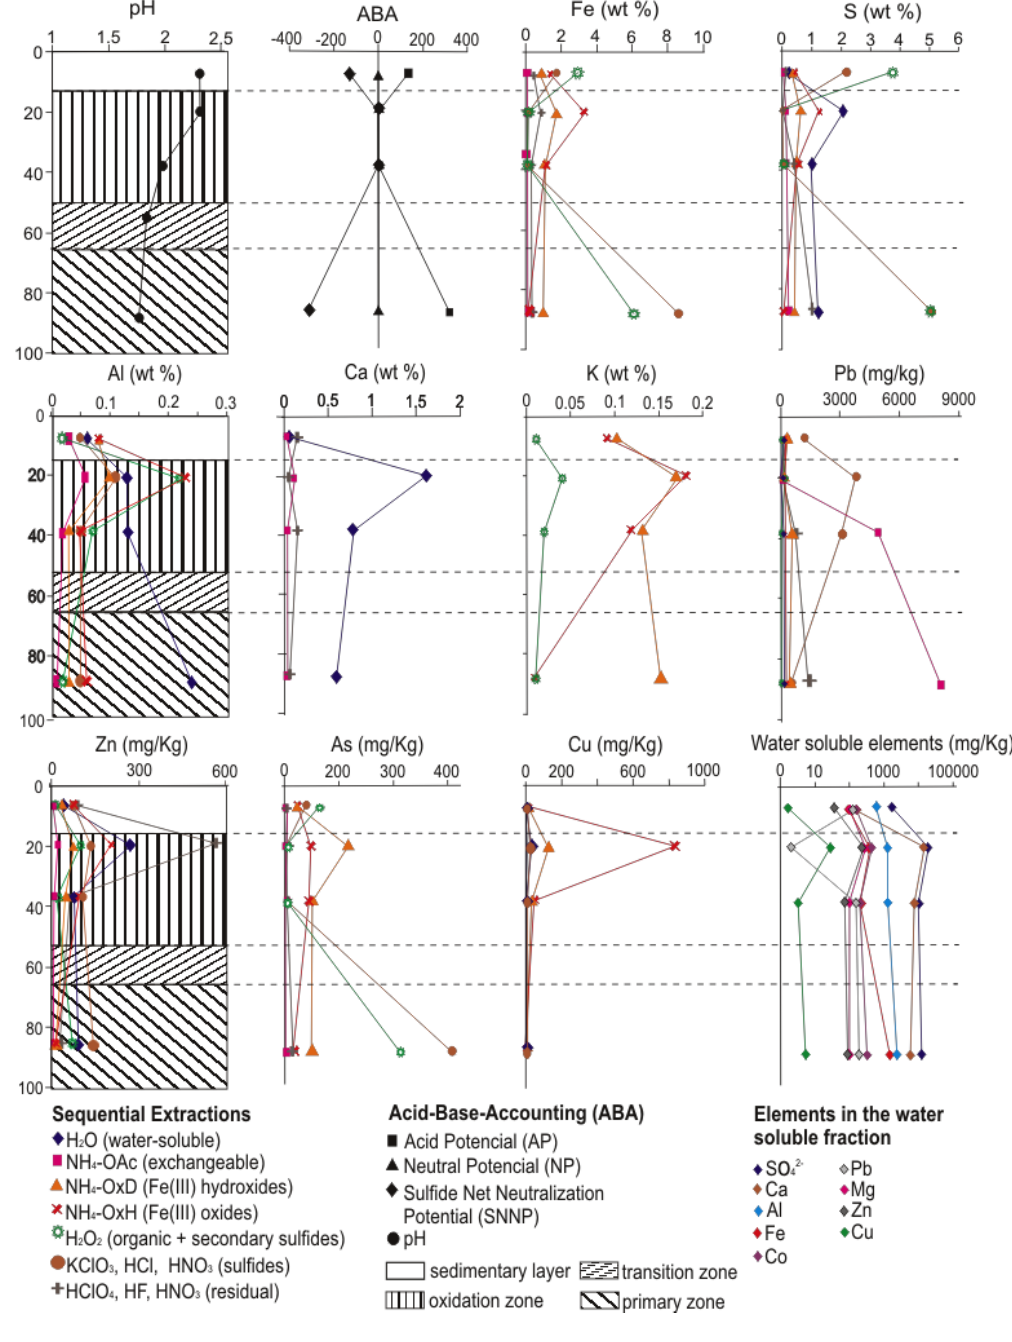
Figure 8. Results of sequential extractions from the representative DC2-P2 profile from DC2 tailings impoundment at the Pan de Azúcar mine. For better visibility, the concentration of the residual fraction of K and Al are not shown in this figure. Data including elements that are not shown in this figure are presented in Table S1 (supplementary